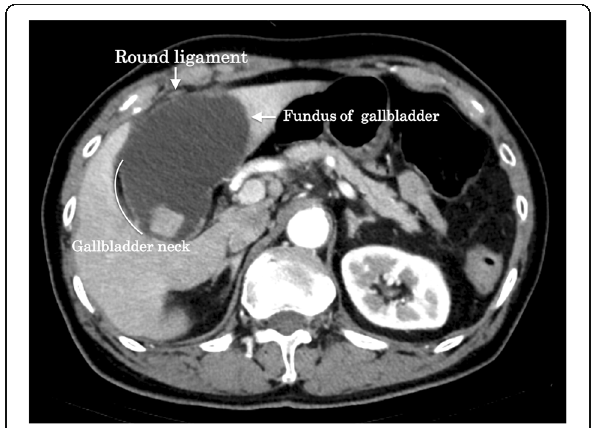
Fig. 1 Abdominal contrast-enhanced computed tomography findings. The fundus of the gallbladder was located centrally beyond the round ligament (white arrow)